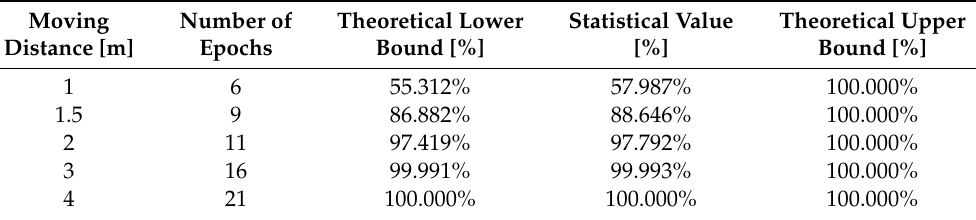
Table 4. Success rates as function of the geometry